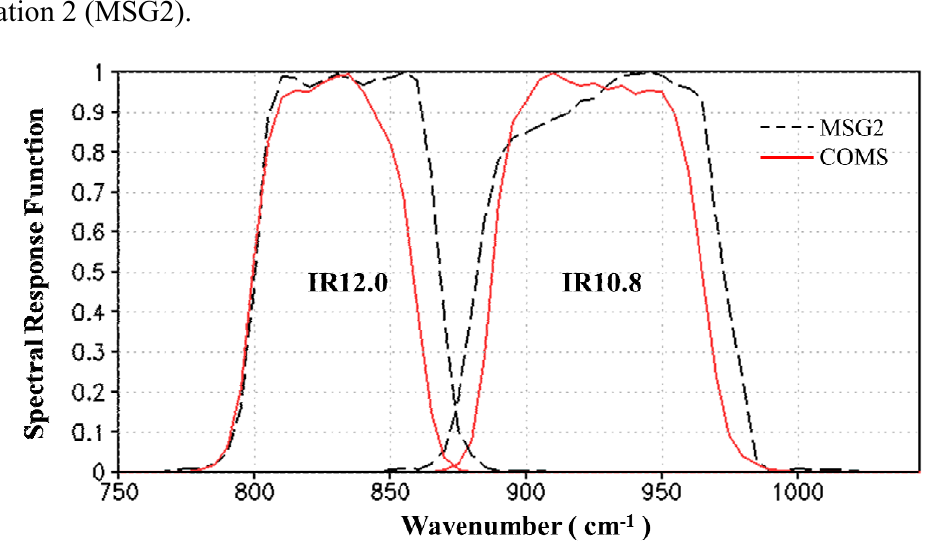
Figure 2. Comparison of COMS IR1 and IR2 spectral response functions with those from Spinning Enhanced Visible and Infra-Red Imager (SEVIRI) on Meteosat Second Generation 2 (MSG2).